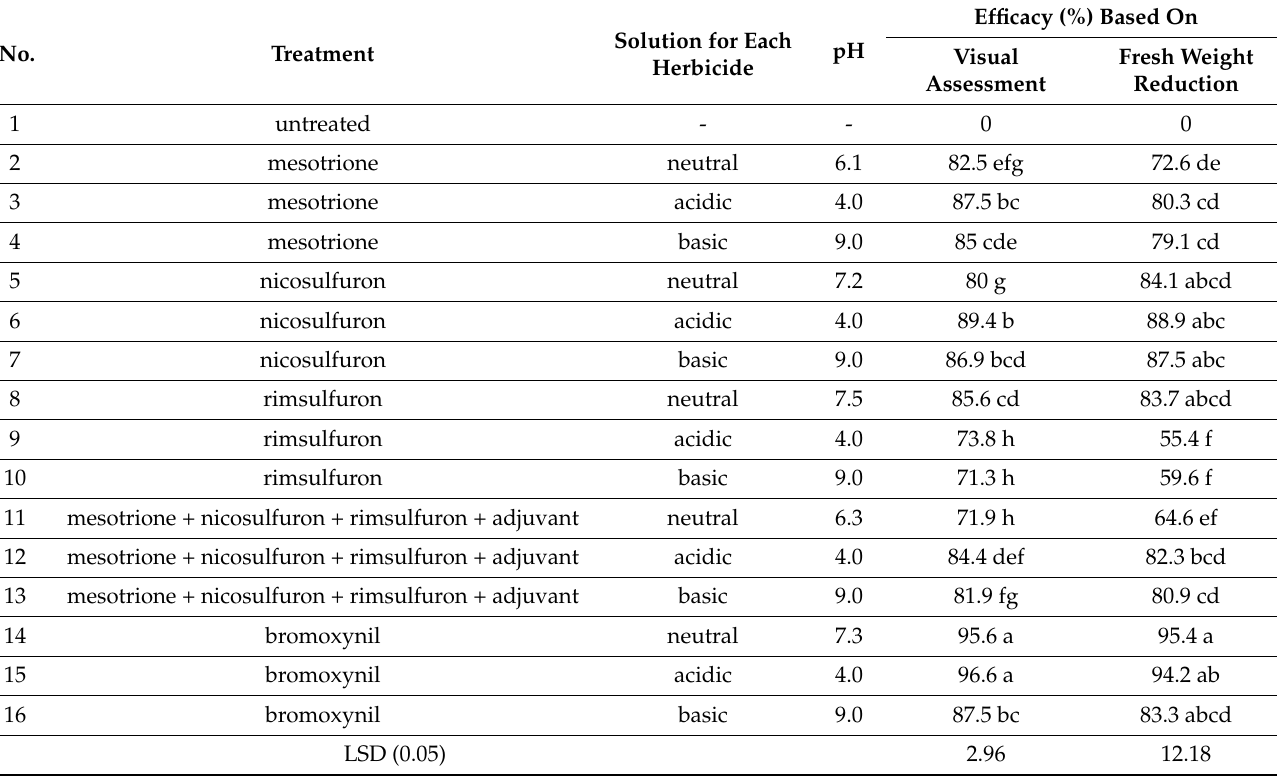
Table 1. Impact of spray solution pH on herbicides efficacy against volunteer oilseed